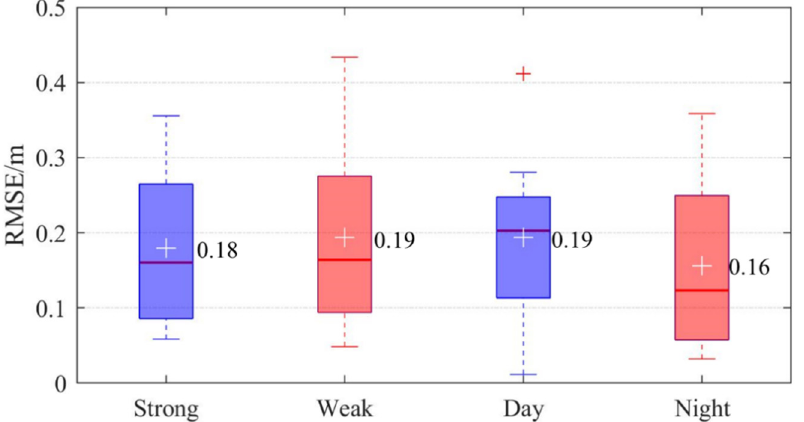
Figure 4. Box plot of RMSE between ICESat-2 water level data and in situ water level data for the Mekong River under different data acquisition conditions. The white crosses express the average of RMSE. The red lines in the box express the median of RMSE. The red crosses express outlier.